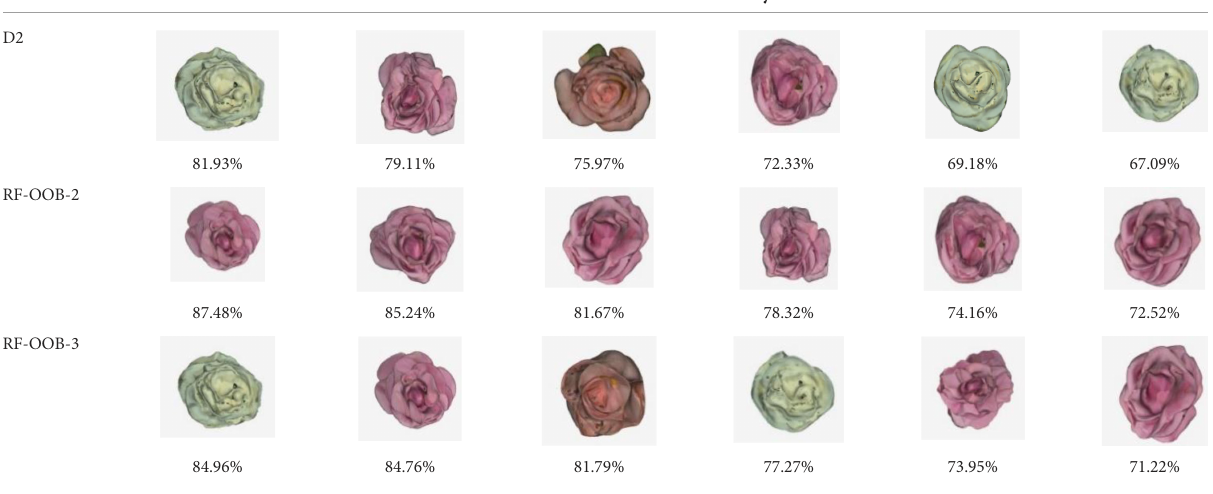
TABLE 6 Retrieval results of 3D model of Guerlain rose fl owers.